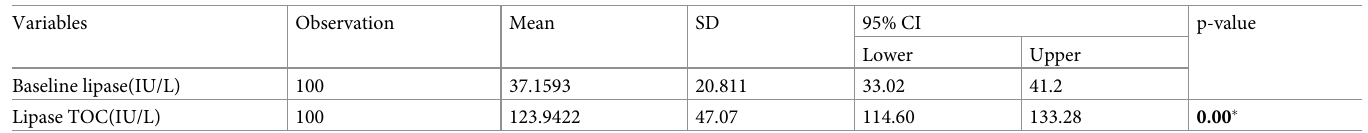
multicollinearity were checked by binary linear regression to perform multilinear linear regression analysis. Multivariate analysis was done for study variables, including age, educa- tional status, religious, and baseline amylase. It showed that serum amylase after treatment had a significant association with age (r = 2.25, p-value = 0.022) and baseline amylase (r = 0.366, p- value = 0.05) level. It indicates the presence of a one year increase in age increases serum amy- lase after treatment by 2.25. A one unit increase of base line serum amylase increase serum amylase after treatment by 0.367 keeping other variables constant. Multivariate analysis of serum amylase with its baseline value and age expressed (as shown in Table 6).